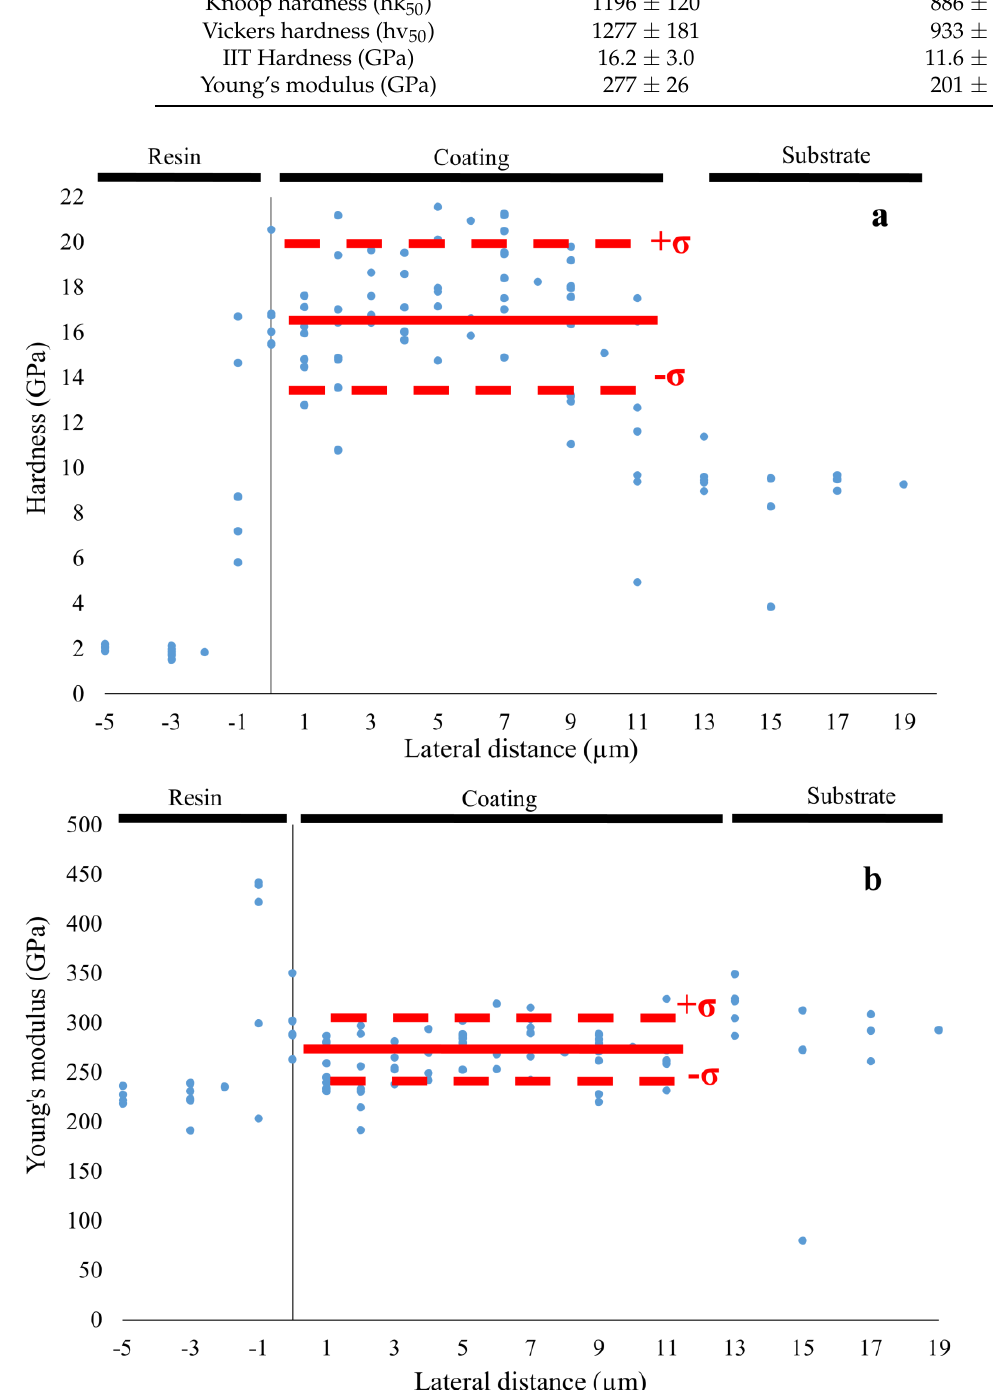
Figure 5. Hardness ( a ) and Young’s modulus ( b ) of the heat-treated deposit. The average value is drawn (continuous red line), as well as the standard deviation (dashed red line).